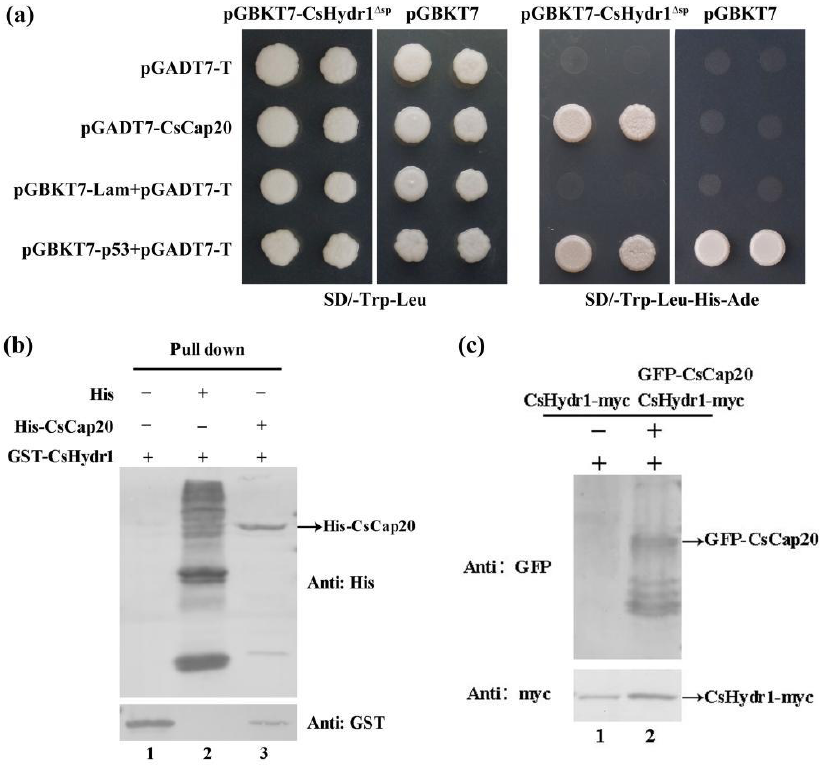
Figure 6. Identification of the interaction between CsHydr1 and CsCap20. ( a ) Confirmation of the interaction between pGADT7-CsCap20 and pGBKT7-CsHydr1 Δ sp by yeast two-hybrid assay. pGBKT7-p53+pGADT7-T is the positive control; pGBKT7-Lam+pGADT7-T is the negative control; ( b ) HIS pull-down results between His-CsCap20 and GST-CsHydr1. Lane 1 is positive control of GST-CsHydr1; Lane 2 is negative control 6 × His null protein and GST-CsHydr1 protein; Lane 3 is His-CsCap20 protein and GST-CsHydr1 protein; ( c ) Co-IP results between GFP-CsCap20 and CsHydr1-myc. Lane 1 is the control protein from the transformant expressing CsHydr1-myc only; Lane 2 is the protein from the transformant expressing both GFP-CsCap20 and CsHydr1-myc. +, protein added, − , protein not added.